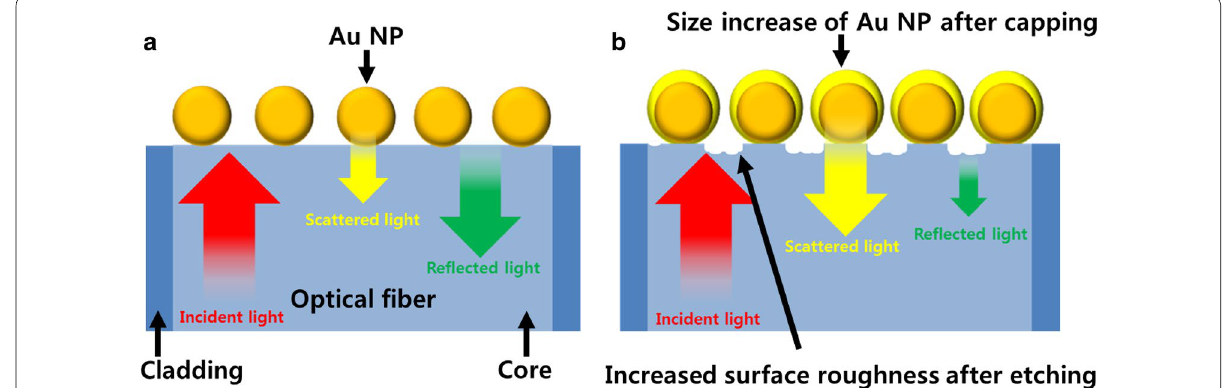
Fig. 1 Schematic diagram of the FO‑LSPR sensor a without and b with Au capping and etching